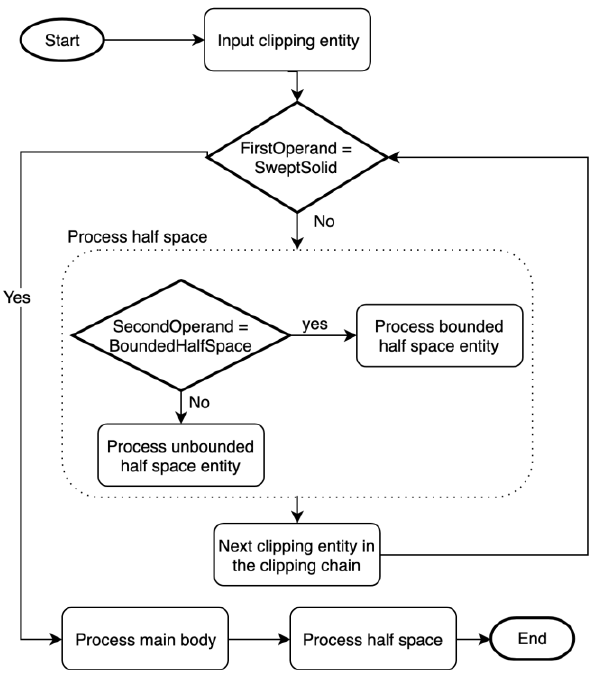
Figure 5. Algorithm for processing clipping entity.